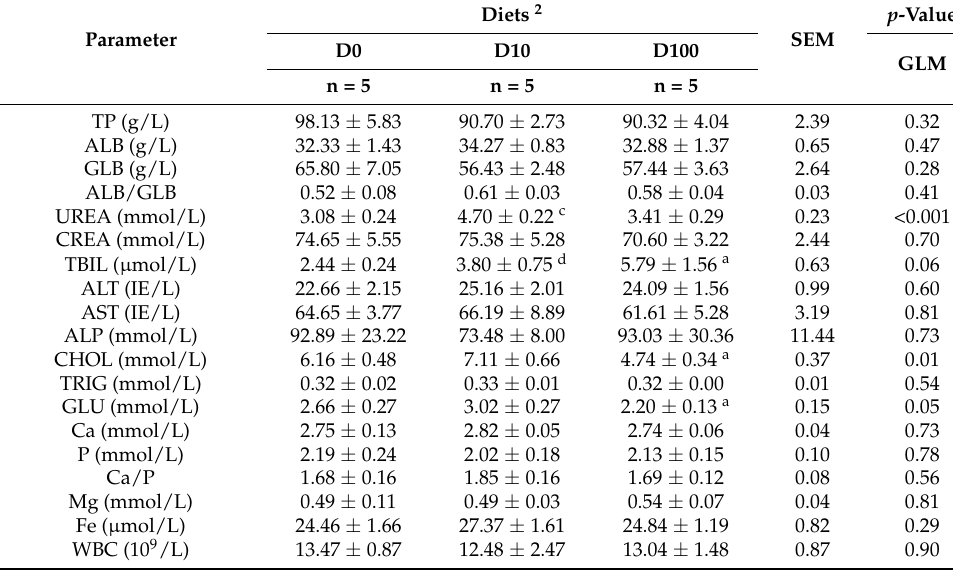
Table 8. Biochemical and morphological parameters of the blood 1